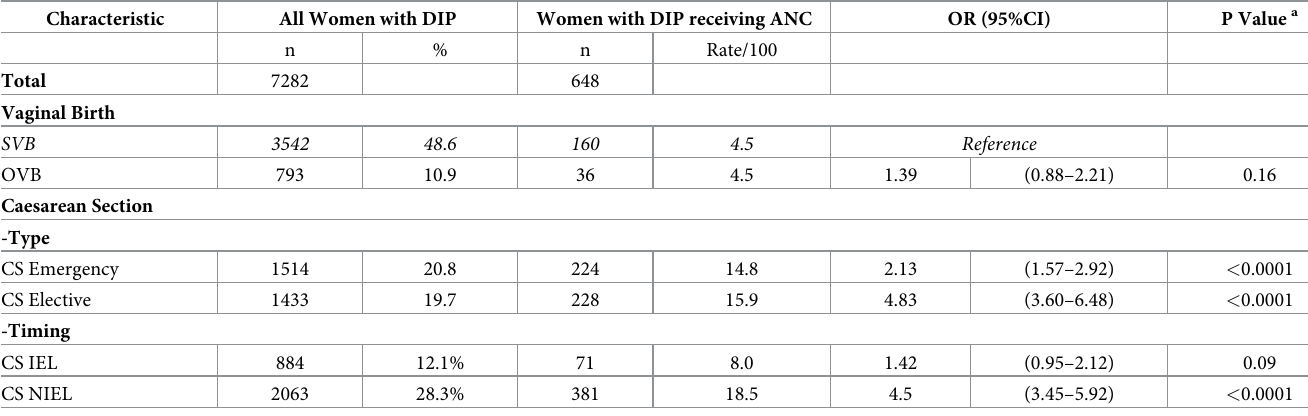
Table 2. Comparison of rates of ANC administration by mode of